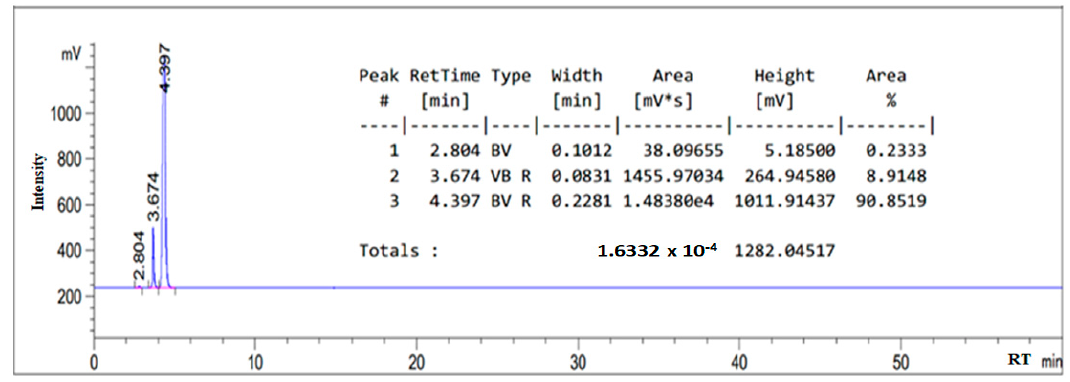
Figure 1. HPLC chromatogram for 0.5 wt.% intermediate of as ‐ synthesized surfactant.